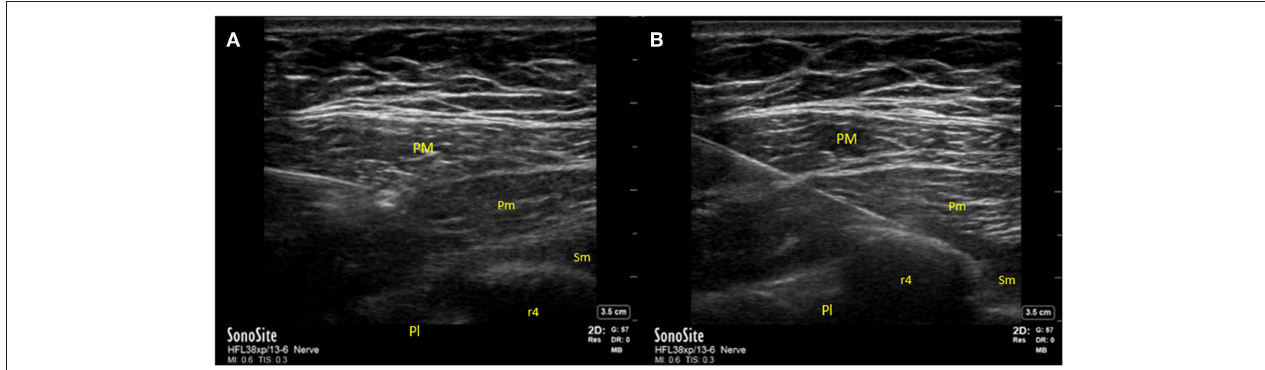
FIGURE 2 | Ultrasound image with identification of relevant structures for Pectoralis plane block. (A) PECS I block and (B) PECS II block. PM, pectoralis major muscle; Pm, pectoralis minor muscle; Sm, Serratus anterior muscle; r4, fourth rib; Pl,